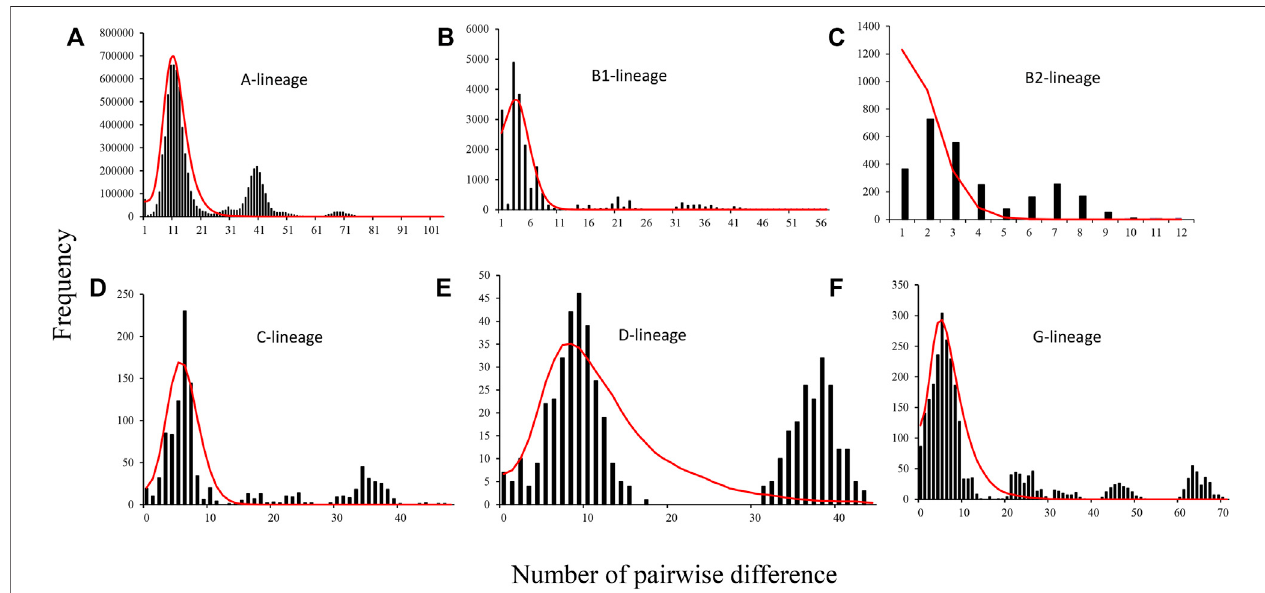
FIGURE 3 | Mismatch distributions for goat mtDNA lineages. (A) – (F) Lineage A, lineage B1, lineage B2, lineage C, lineage D, and lineage G, respectively. The histogram represents observed values, and the red line represents simulated values.